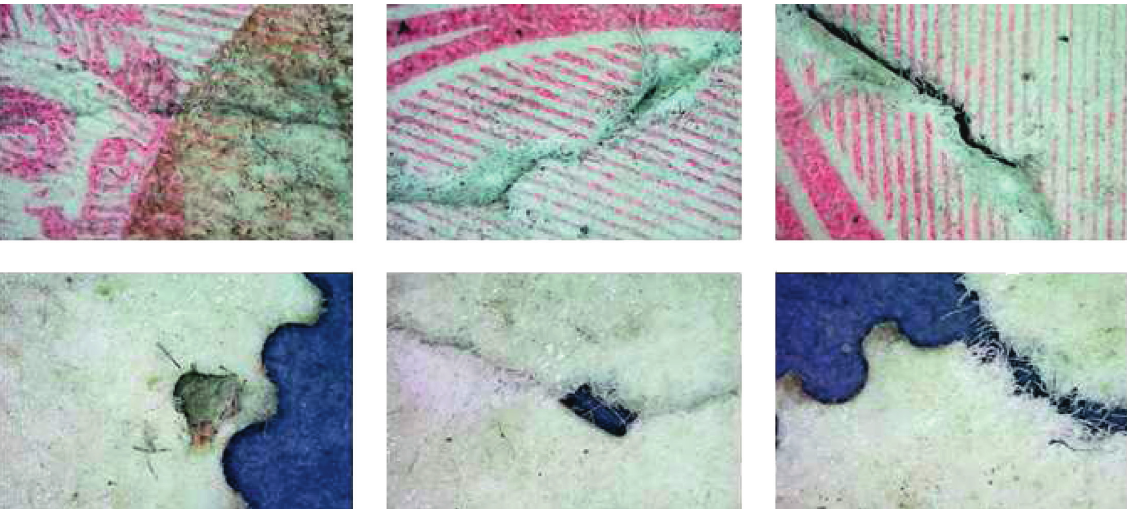
Figure 3: Various tears and spots on the red stamp and the weakness of the outer part (serrated margins) at 10X.